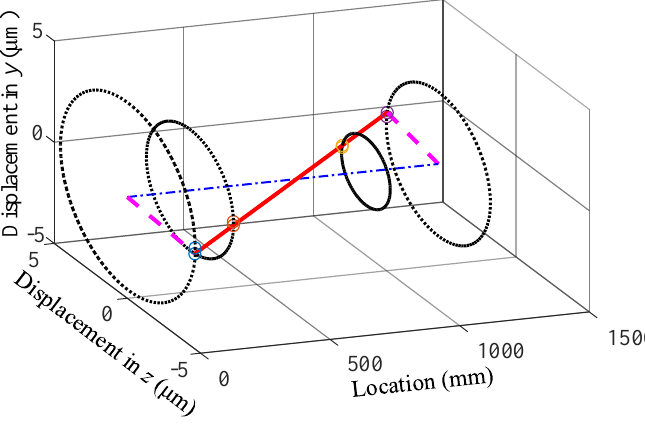
Figure 8. Response of high-pressure rotor at high speed. ( a ) time domain response; ( b ) frequency domain response.